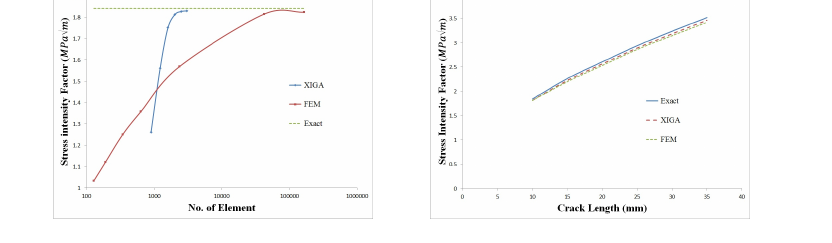
Figure 10. Study of Figure 11. Comparison of SIF convergence and comparison of at different crack lengths. SIF. √ Table 6. Stress intensity factor ( K 1 ) , ( pa m ) × 10 7